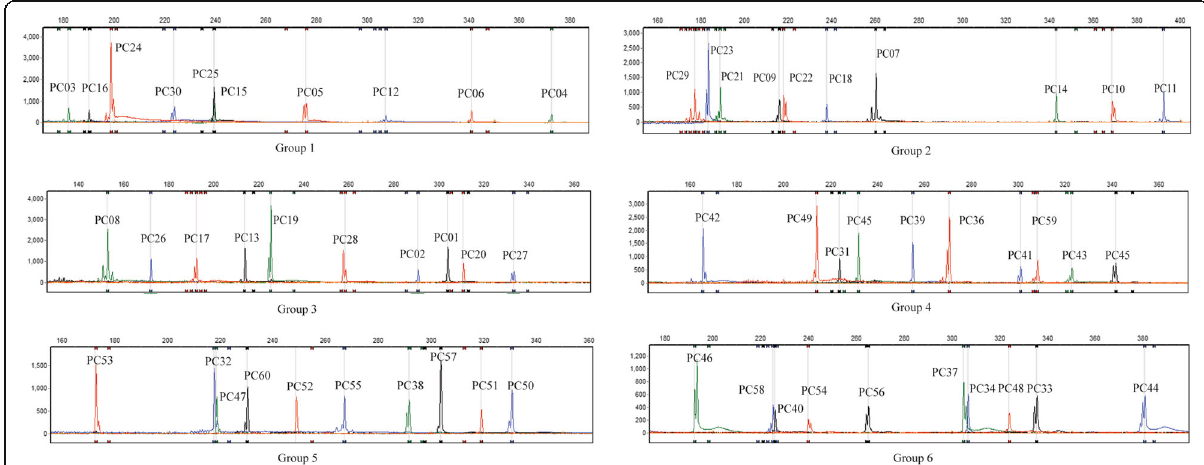
Fig. 2 Capillary electrophoresis results for cotton variety Zhongmiansuo 49. In total, 60 SSR primers were divided into six groups. Each primer was labeled with a fluorophore as listed in Table 2; the primer numbers for each group are listed in Table